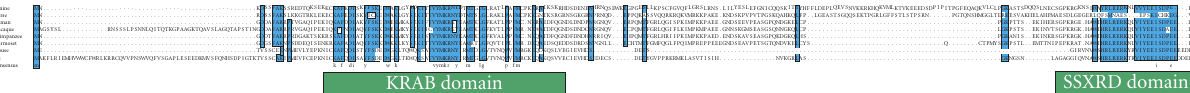
Figure 1: Protein homology and conserved domains among SSX orthologues. Shown is a sequence alignment of species-specific SSX protein sequences from canine, horse, human, macaque, chimpanzee, marmoset, mouse, and rat sources. Blue highlighting represents > 75% sequence identity with consensus sequence shown on the bottom. The KRAB and SSXRD domain regions denoted by solid green bars are shown below the sequence